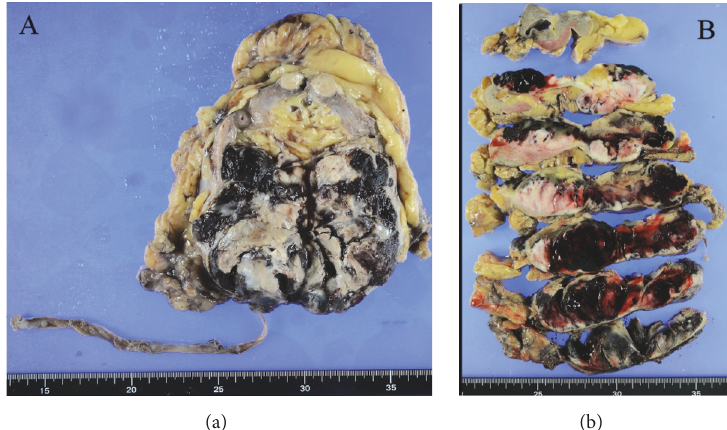
Figure 3: Gross findings of the tumor. 55 × 94 mm white to tan tumor occupied the lower portion of the right kidney. Marked hemorrhage was found (a, b).